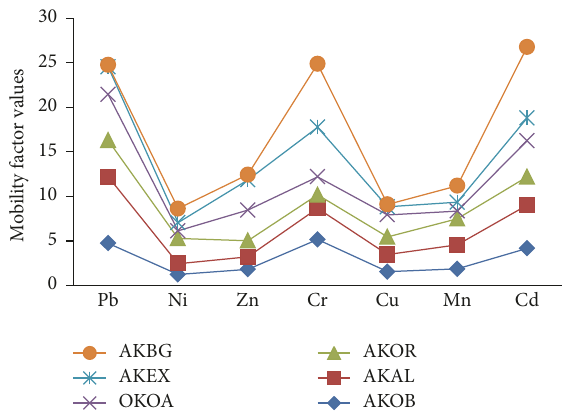
Figure 2: Plot of mobility factors of the studied metals in different sites of Akure.